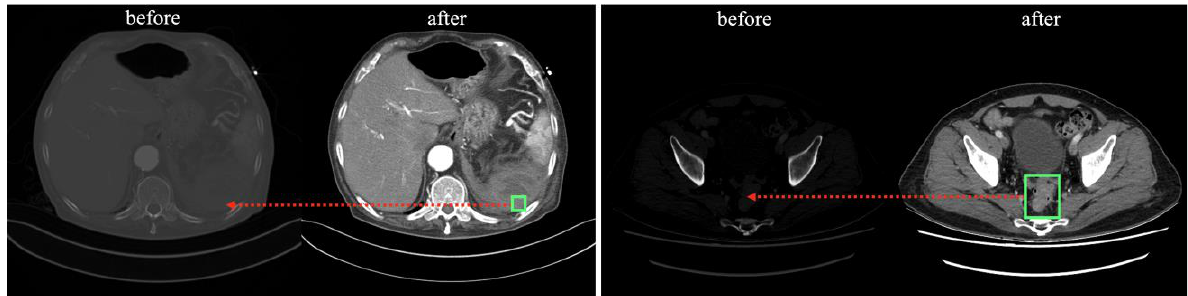
Figure 2. Comparison of before and after processing of DICOM file.